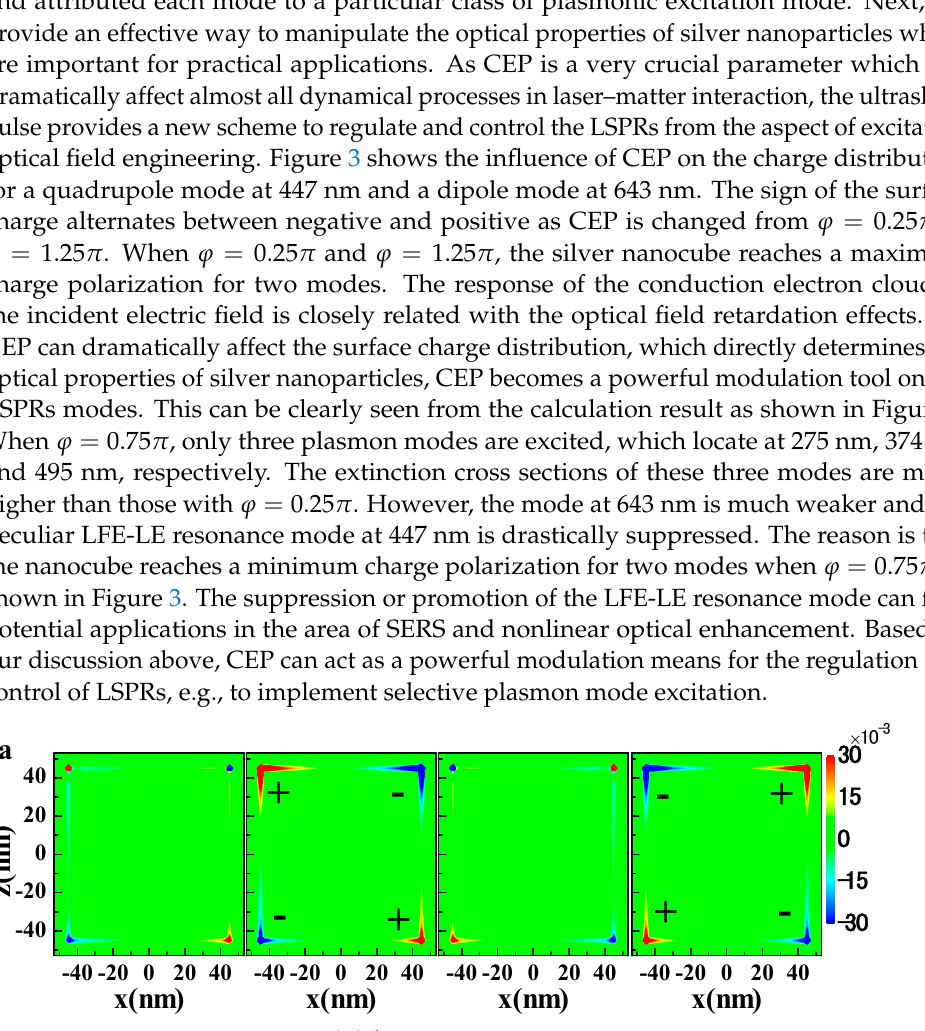
643 nm λ= -0.25 ϕ π= 0.25 π with , ,